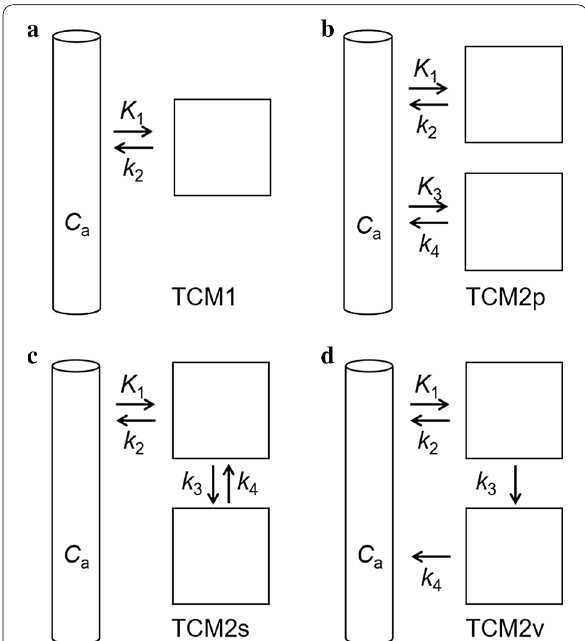
Fig. 2 Compartment models evaluated in this study. a One-tissue compartment model (TCM1). b Model with two parallel tissue compartments (TCM2p) both directly accessible from the input compartment. c Two-tissue compartment model with the two-tissue compartments in series (TCM2s), as applied for neuroreceptor PET. K 1 or